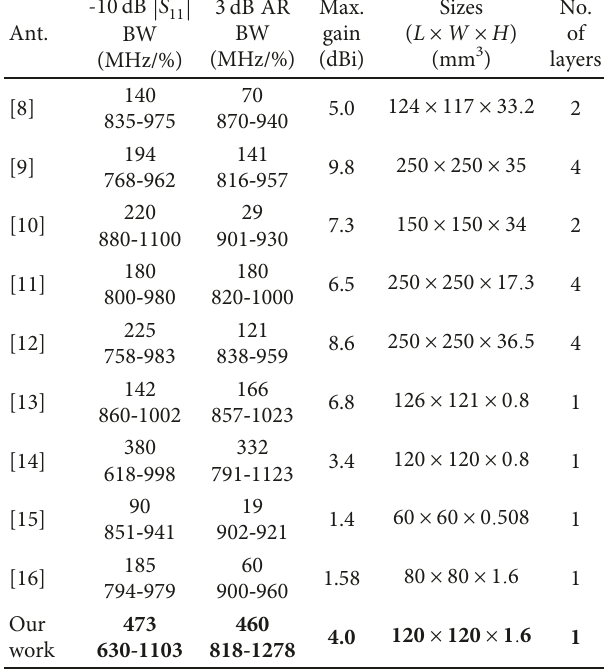
Table 2: Comparison between the proposed antenna and other CP reader antennas.